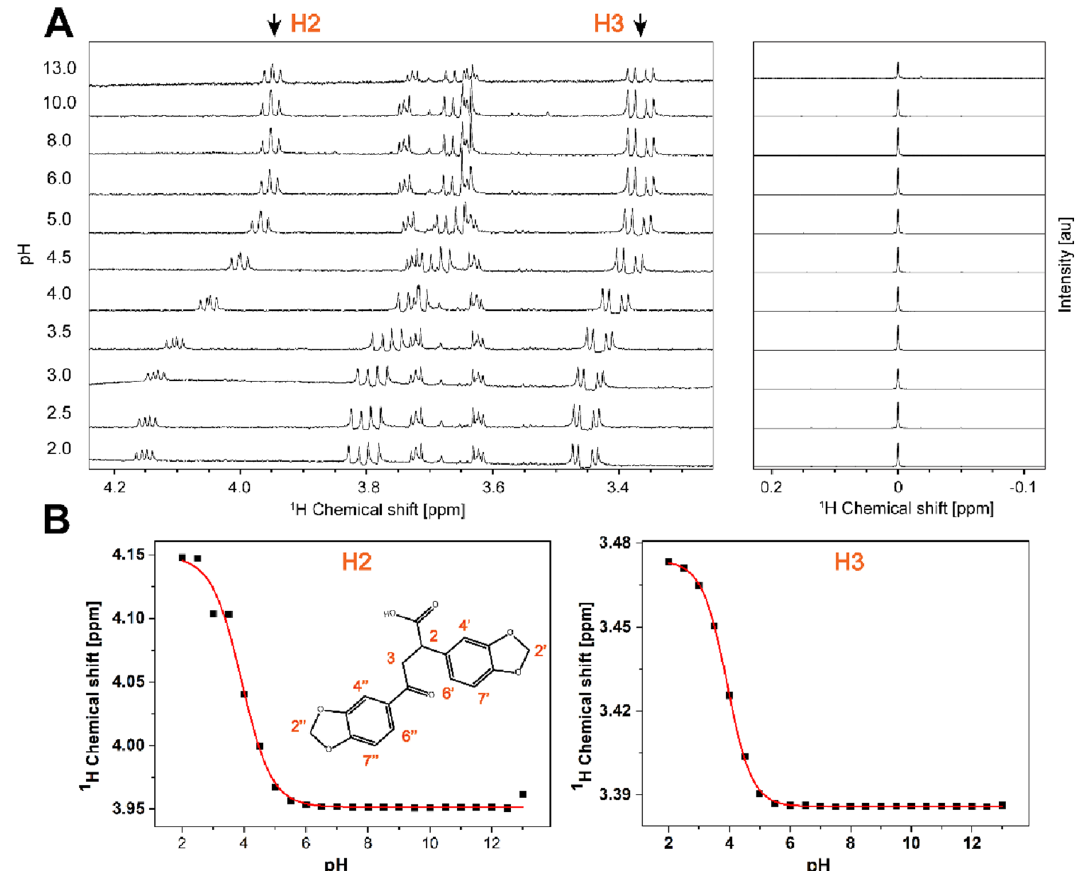
Figure 6. Determination of the pKa value for 7.44 by 1 H NMR. (A) 1 H NMR spectra of 200 µM of 7.44 measured from pH 2 to 13 at 298 K at 600 MHz. Sodium 2,2-dimethyl-2-silapentane-5-sulfonate (DSS) was used for chemical shift referencing and calibrated to a zero ppm value. ( B ) Titration curves obtained from the 1 H chemical shifts of the protons H2 and H3 as a function of pH. The pKa values were calculated using the Henderson-Hasselbalch equation 25 , yielding a pKa value of 3.99 ± 0.01 and 3.93 ± 0.01 of the carboxylic group as indicated by proton H2 and H3,